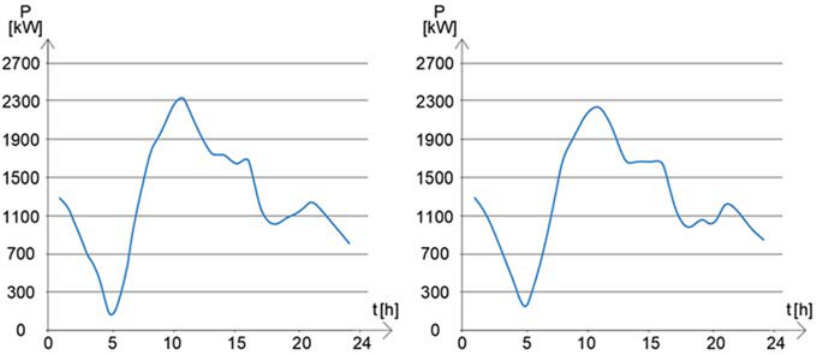
Figure 13. Type daily diagram and its standard for (Thursdays).